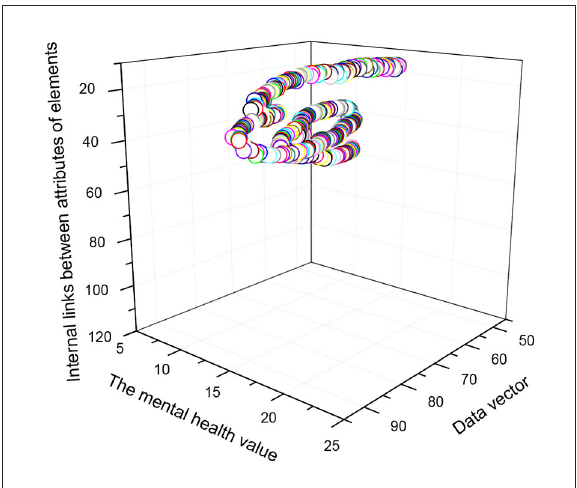
data selection, psychological data cleaning, psychological data integration, psychological data specification and